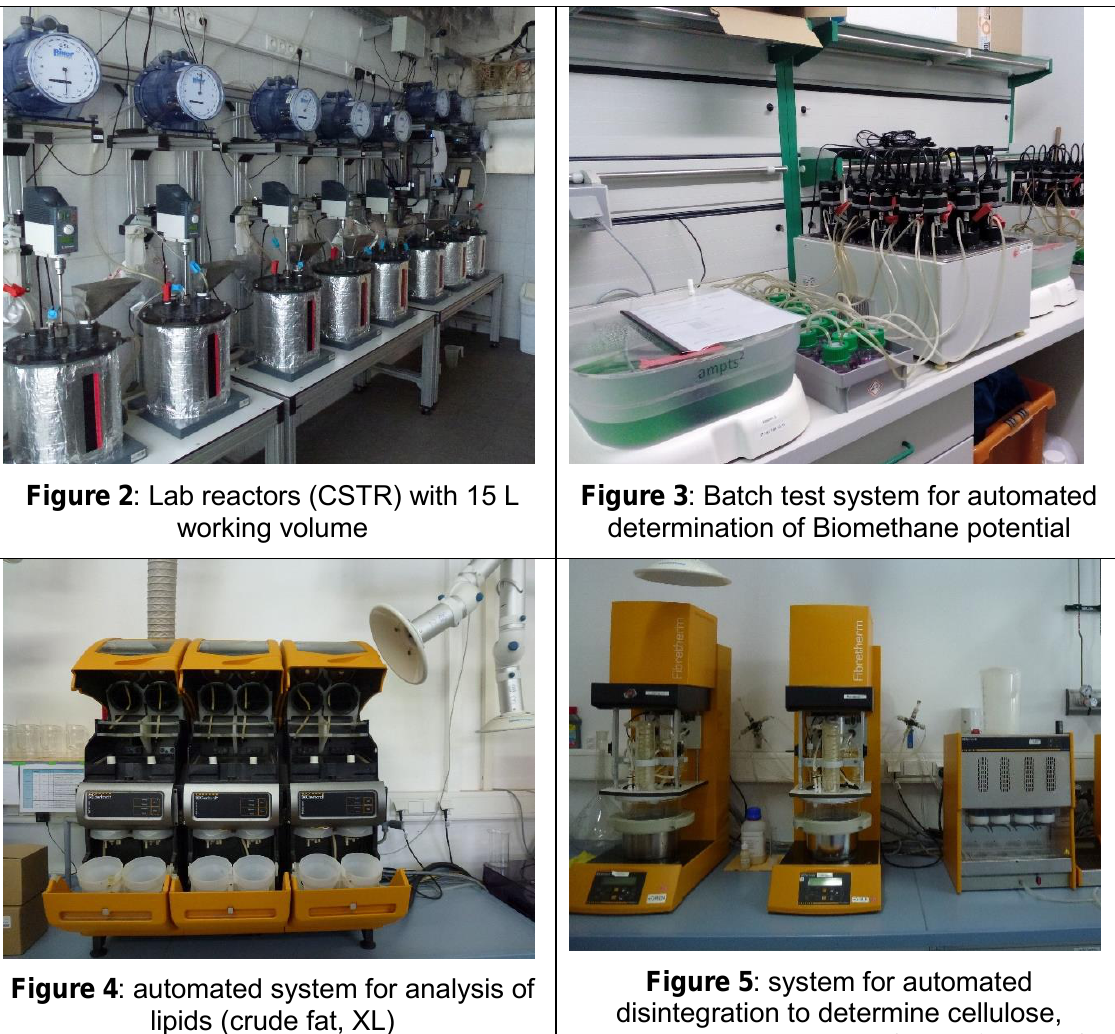
Figure 4 : automated system for analysis of lipids (crude fat, XL)